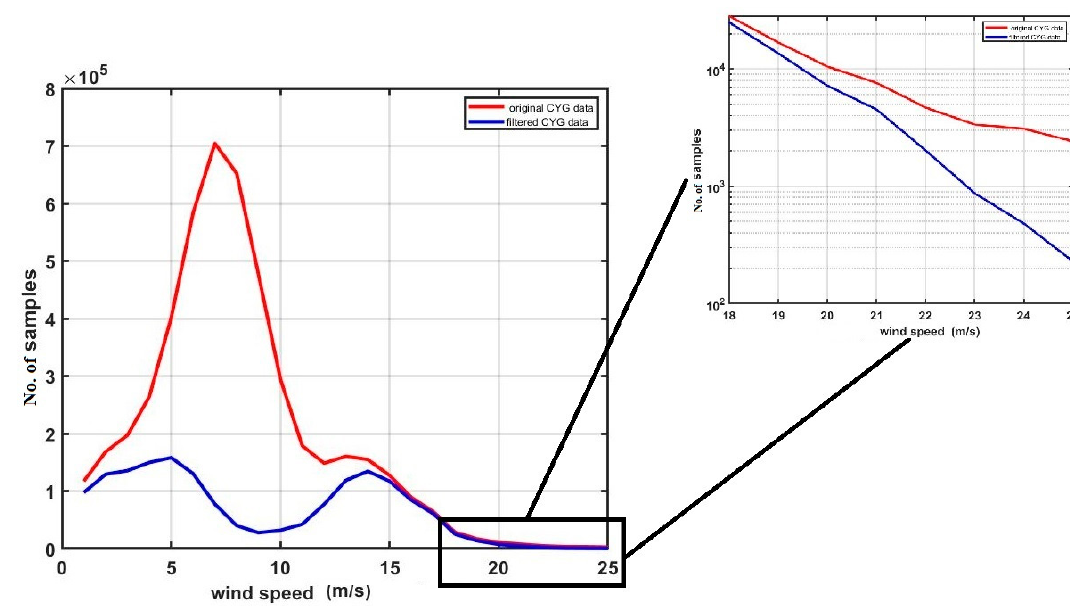
Figure 9. Distribution of outliers at different MERRA-2 wind speed bins before and after QC filter.